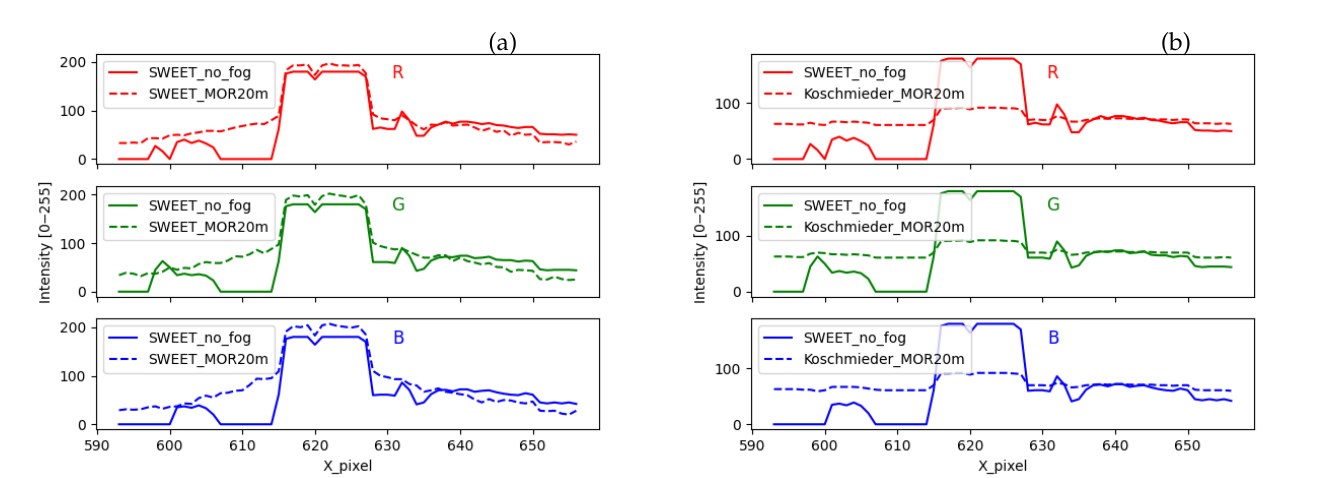
Figure 16. Comparing the intensity of a pixel line for the urban scene simulated by the SWEET simulator ( a ) and Koschmieder ( b ).